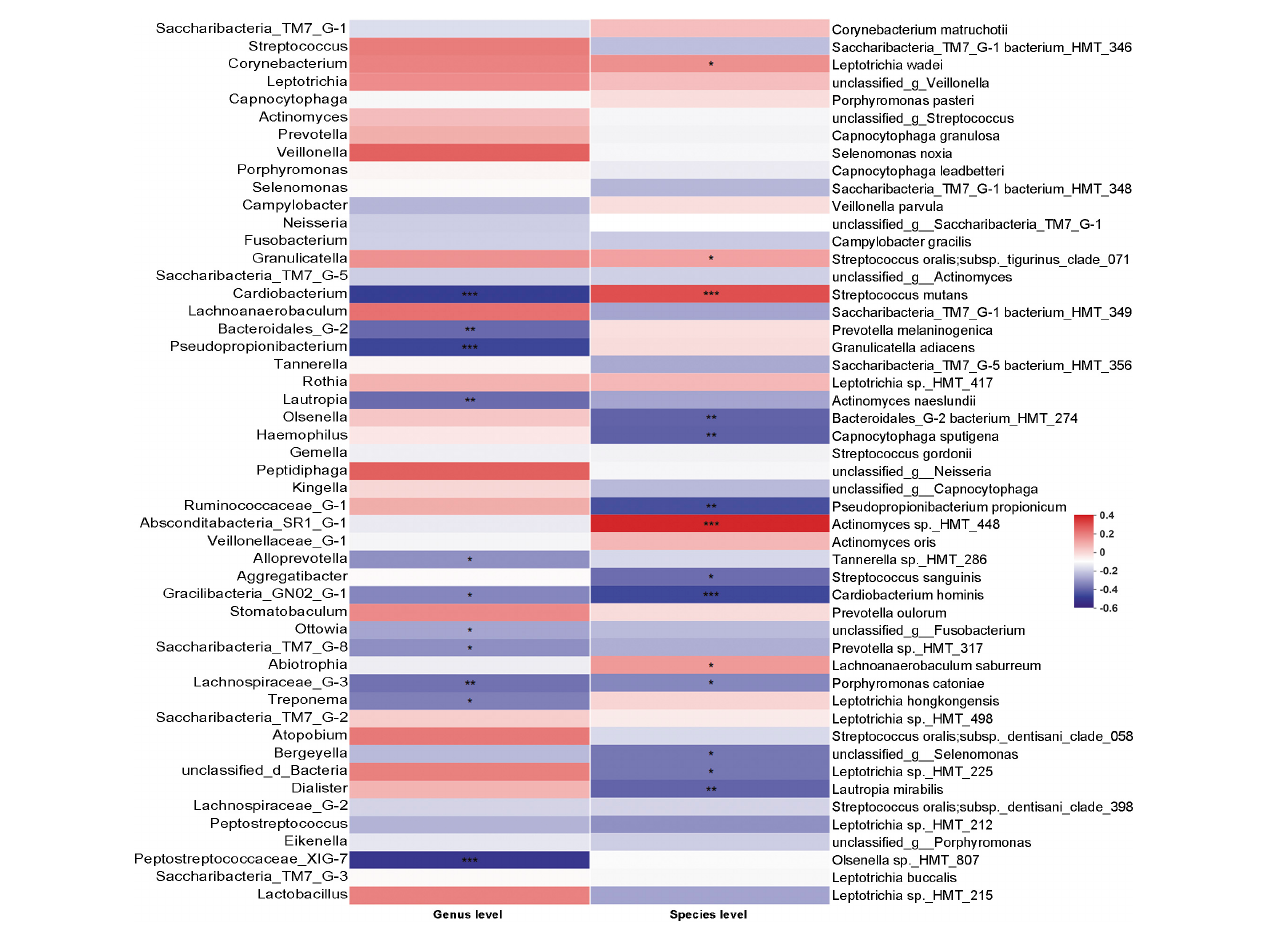
FIGURE6 Correlation analysis between Candida albicans and bacteria based on Spearman correlation coefficient. The correlation between the quantification of C. albicans and the top 50 abundant bacteria genera and species in the rank of relative abundance was evaluated. At genus level, bacteria such as Saccharibacteria_TM7_G-8 negatively associated with C. albicans . At species level, Streptococcus mutans had positive association with the load of C. albicans . Several species such as Streptococcus sanguinis and Cardiobacterium hominis had depleting trend in C. albicans enriched samples. Blocks in red showed positive correlation, while blocks in blue showed negative correlation. Color depth implicated the strength of correlation (* P < 0.05, ** P < 0.01, *** P <